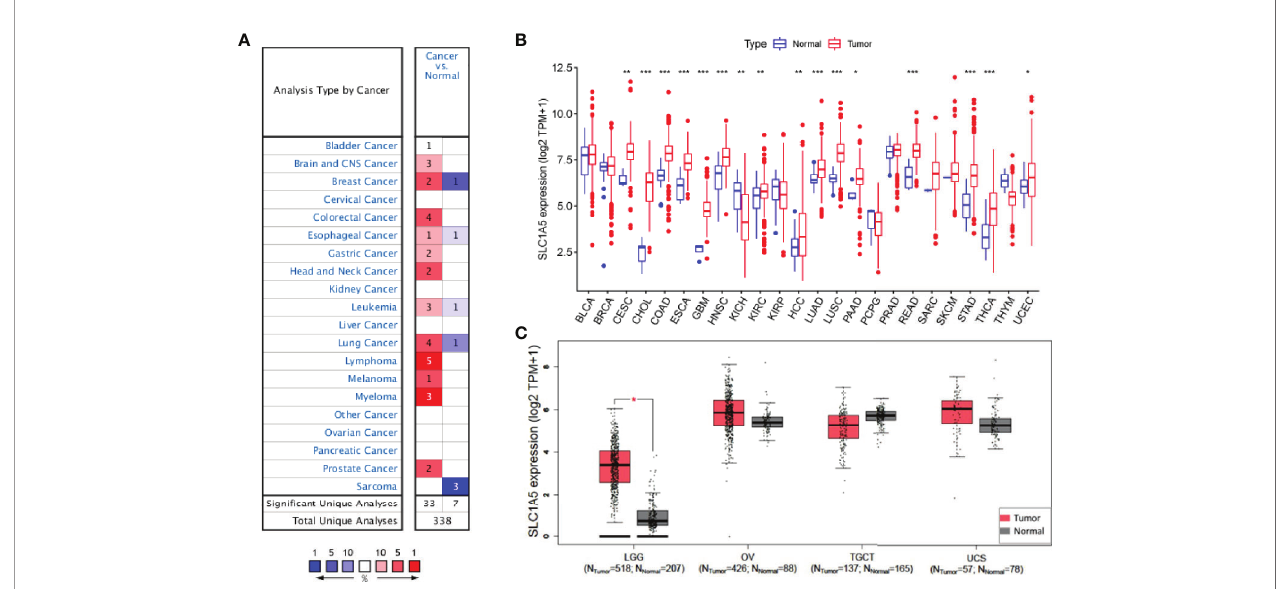
FIGURE 1 | SLC1A5 expression in cancers. (A) Altered expression in different cancer tissues compared with normal tissues in ONCOMINE. Number in each cell is the number of datasets. (B) Expression in different solid tumor types from TCGA database. *p < 0.05, **p < 0.01, ***p < 0.001. (C) Expression in four complementary solid tumor types from TCGA and GTEx projects in